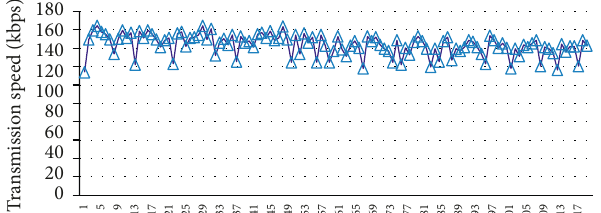
Figure 6: Throughput of scheme 1.